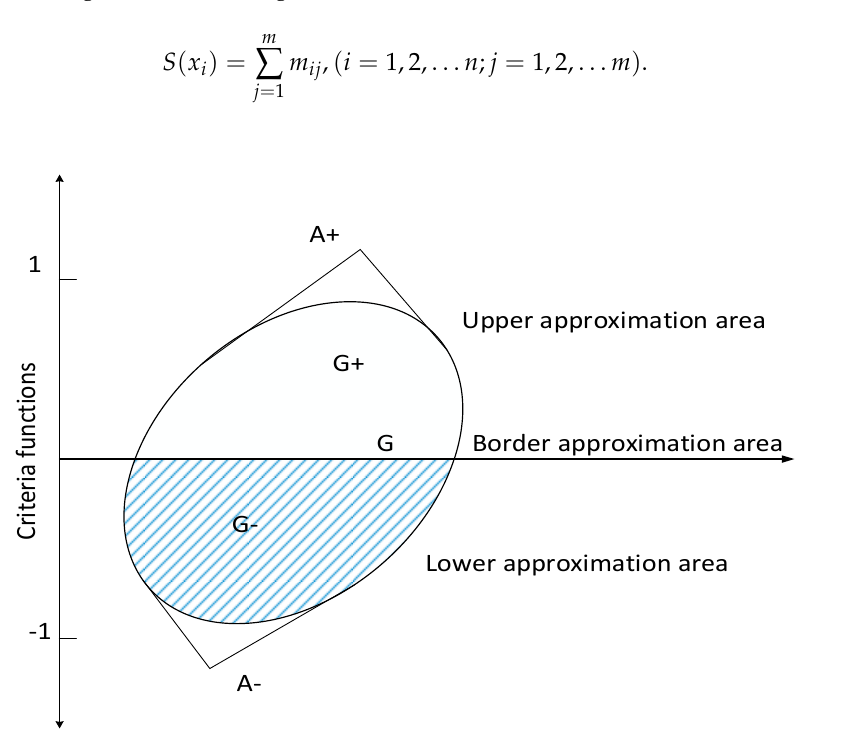
Figure 4. Graphical presentation of G + , G , and G −